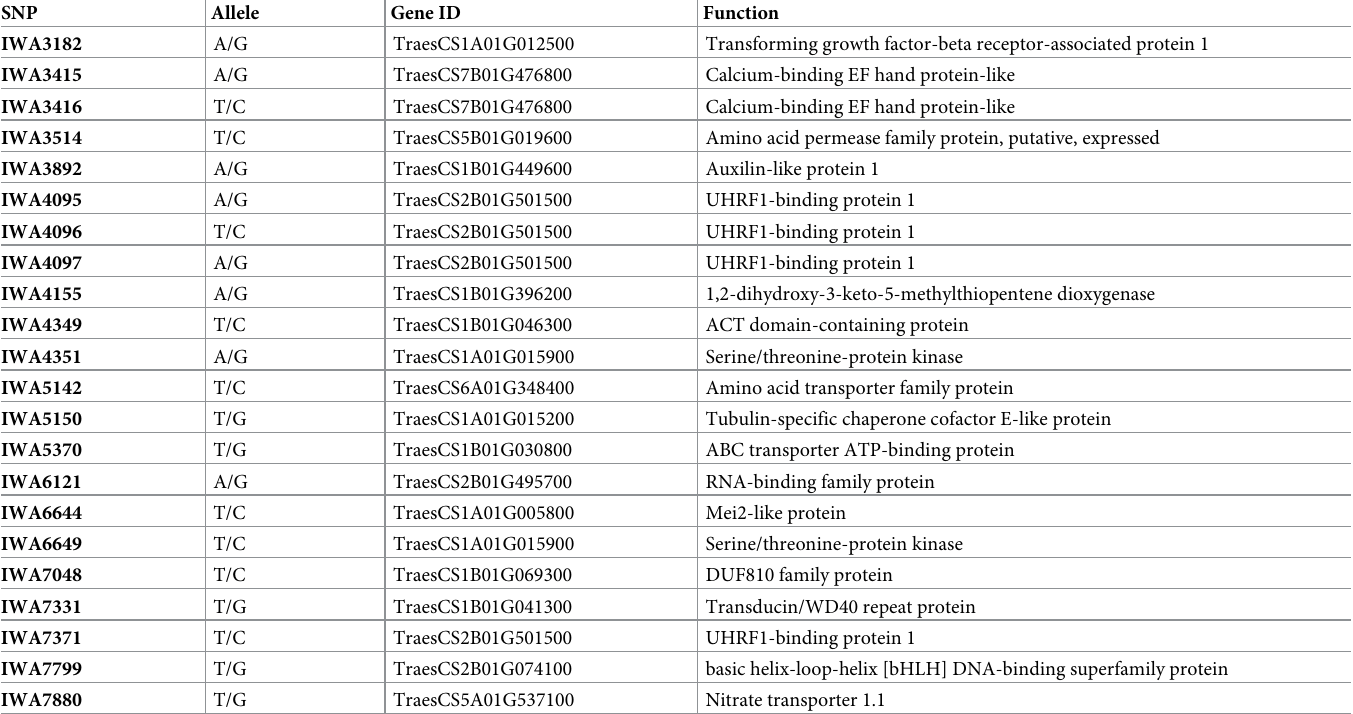
Table 2. Represents genes that have significant stripe rust-resistant